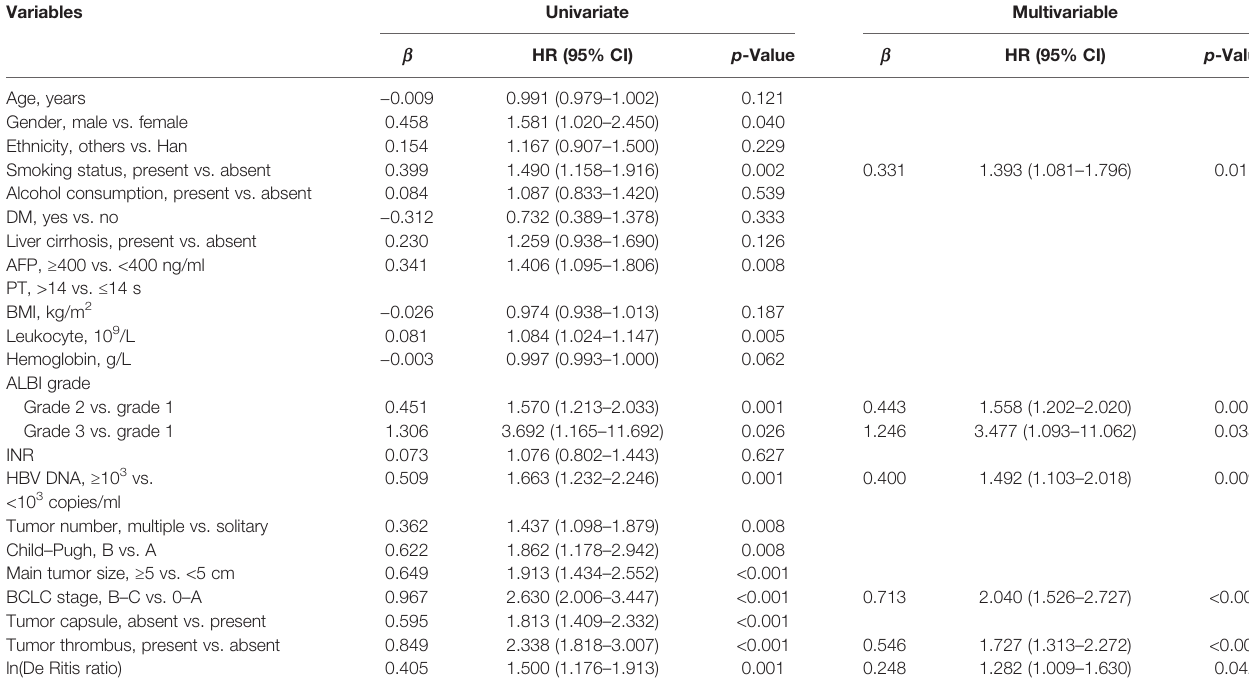
TABLE 3 | Univariable and multivariable Cox regression analyses of factors associated with OS in the training set (N =